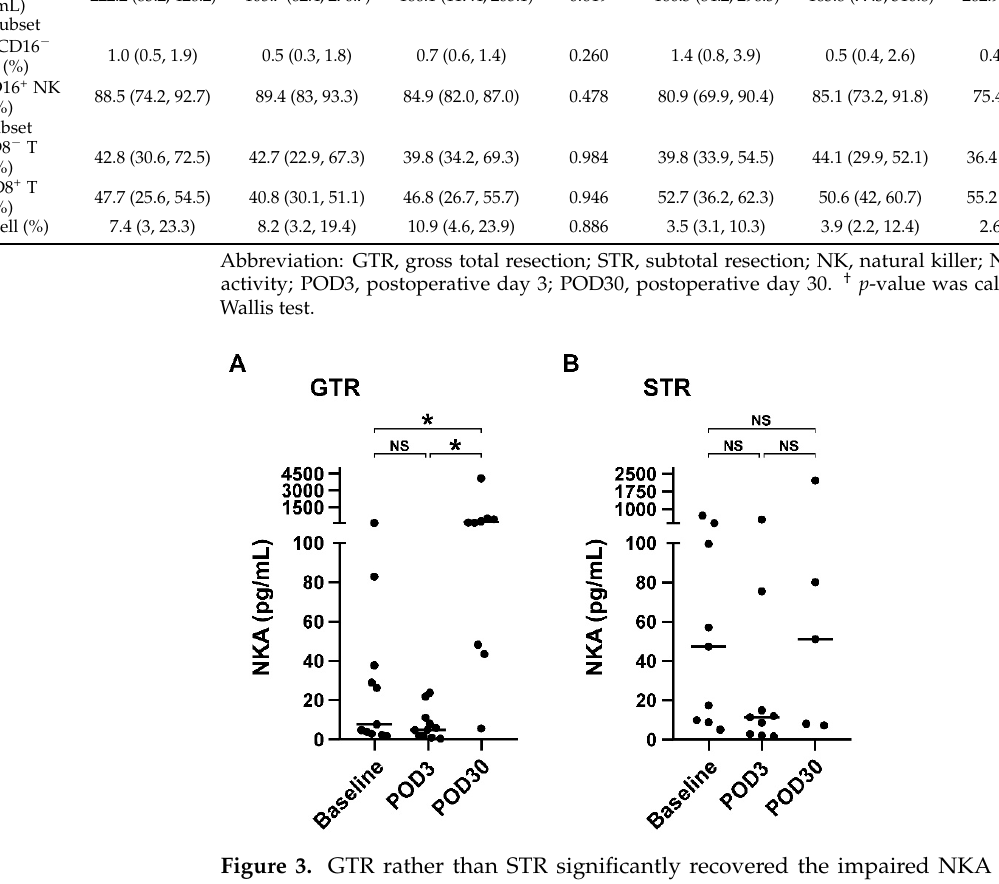
Table 3. NKA and NK cells in glioblastoma patients before and after GTR and STR.